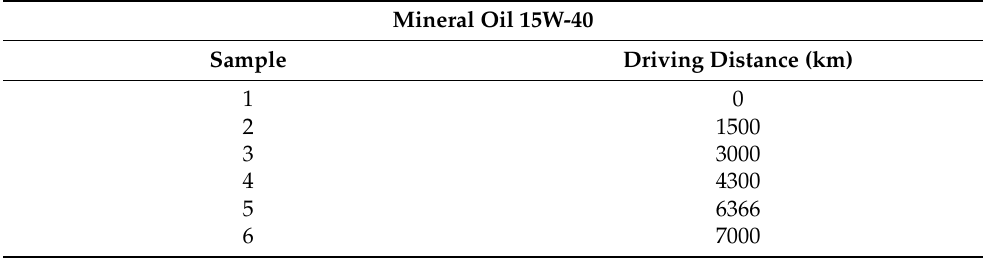
Table 1. Oil samples with their respective driving distance.